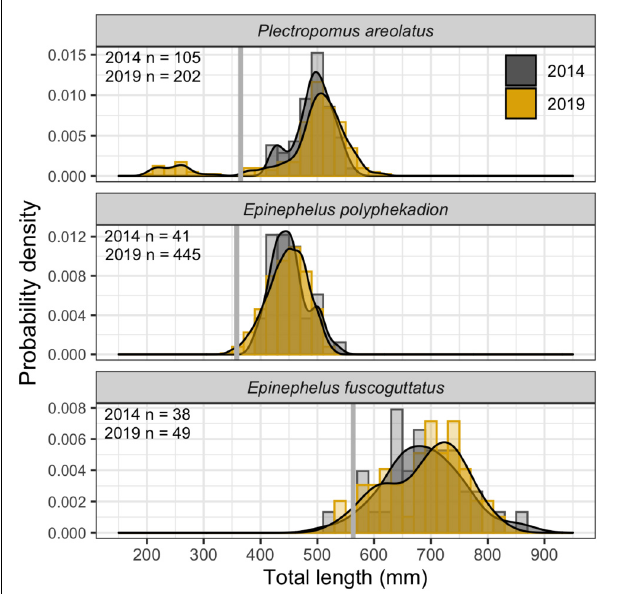
FIGURE 12 | Size frequency distributions for 2014 and 2019 and sample sizes by species and year. Probability density curves are displayed over frequency histograms of total length (20 mm wide bins). 2014 data filled as gray and 2019 data as yellow. Mean estimates of size at maturity ( L 50% ) from Palau are shown as gray vertical